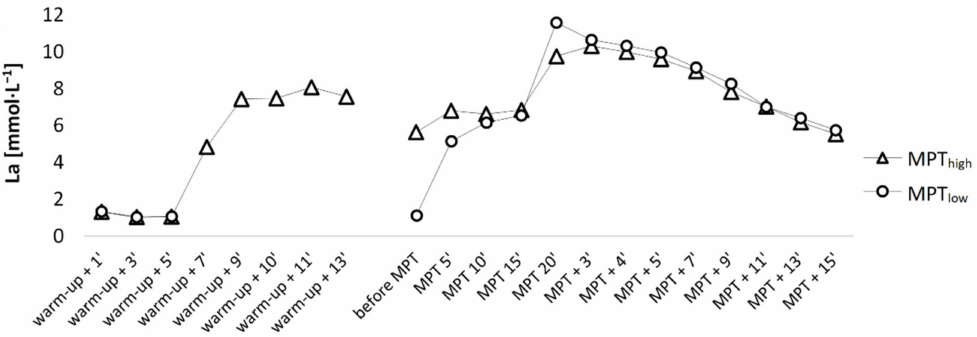
Figure 3. [La] response to both protocols.